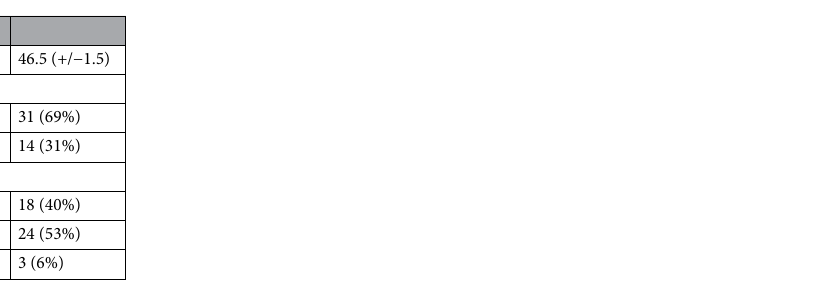
Table 1. Characteristics of the patient cohort with obesity. The age and surgical or endoscopic procedure of all patients is shown (n = 45). Y years, SEM standard error of the mean, n number. *Intragastric balloon (n = 2) and one anastomosis gastric bypass (n =